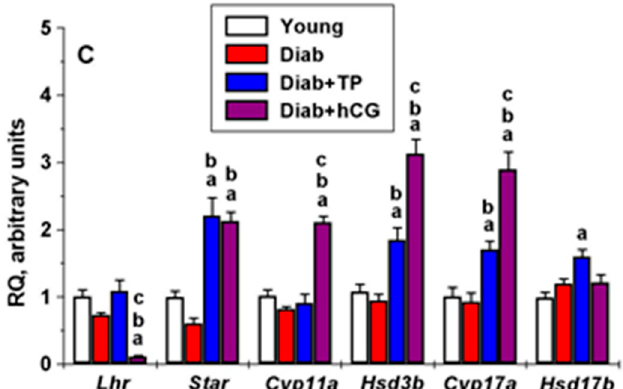
Figure 4. The gene expression in the testes of the young adult ( A ), aging ( B ) and diabetic ( C ) male rats, and the effect of five-day treatment with TP4/2 and hCG. a —the difference between the young adult rats without TP4/2 or hCG treatment and the other groups is significant at p < 0.05; b —the difference between aging/diabetic rats without TP4/2 or hCG administration and aging/diabetic rats with TP4/2 or hCG administration is significant at p < 0.05; c —the difference between the TP4/2- and hCG-treated rats within the young adult, aging and diabetic series is significant at p < 0.05. TP4/2 was administered intraperitoneally at a daily dose of 20 mg/kg, and hCG was administered subcutaneously at a daily dose of 20 IU/rat. The data are presented as the M ± SEM, n = 5.